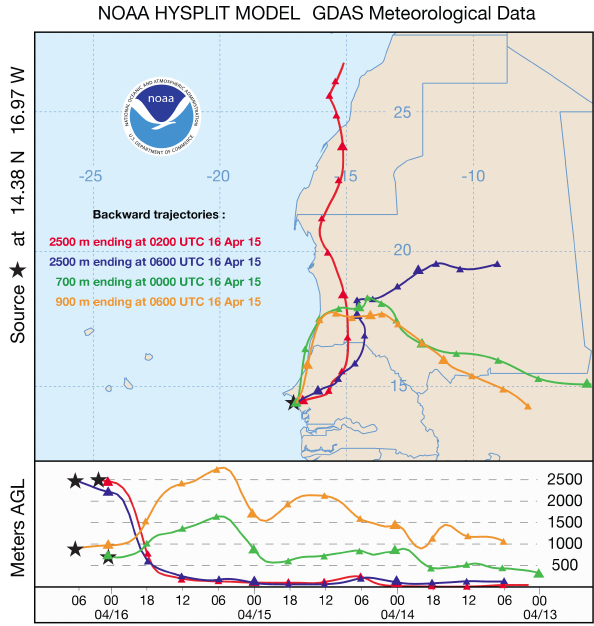
Figure 3. Back trajectories of the air masses ending in Mbour on 16 April 2015 at 2500m (02:00 and 06:00UTC), 700m (00:00UTC), and 900m (06:00UTC). The first two back trajecto- ries correspond layer A from Fig. 1, while the last two back trajec- tories correspond layer B from the same